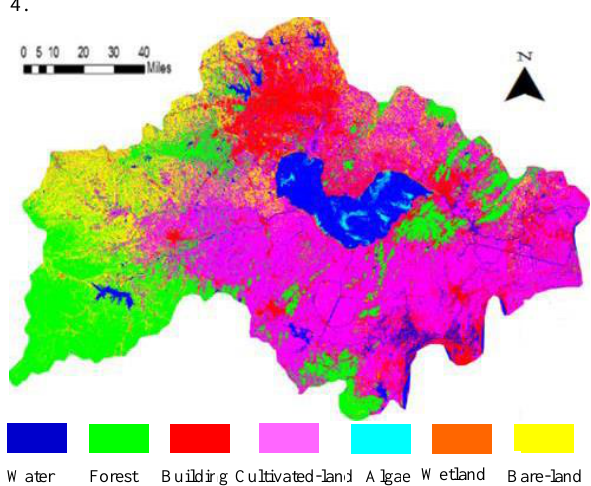
Figure 4 Chaohu Lake basin classification